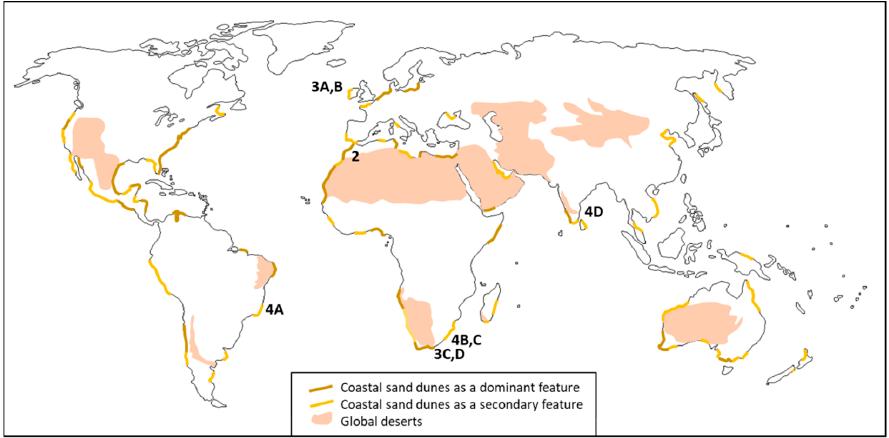
Figure 1. The locations of coastal sand dunes [28] and deserts at a global scale [29], and the locations of Figures 2–4 (bold).